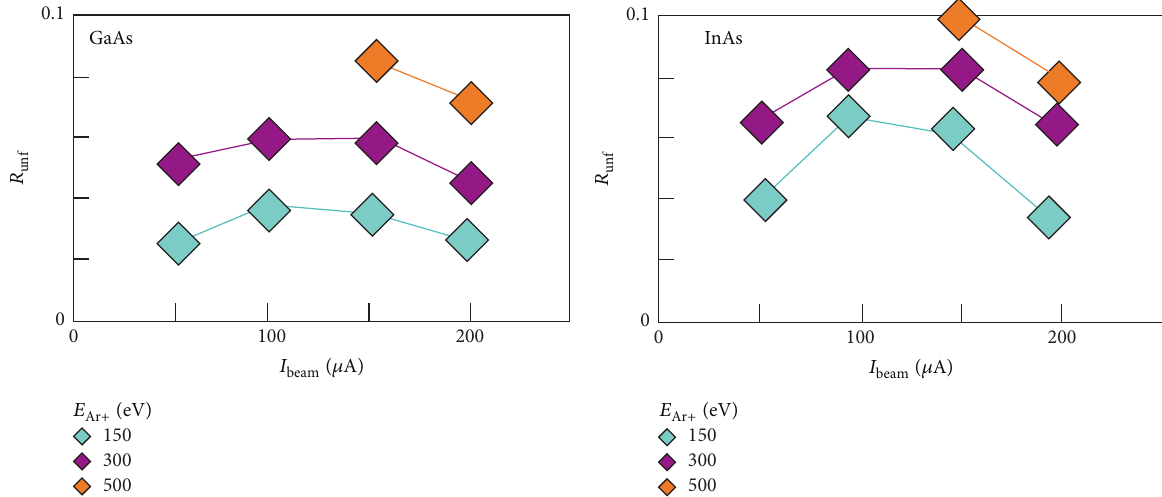
Figure 2: Uniformity-current characteristic for GaAs and